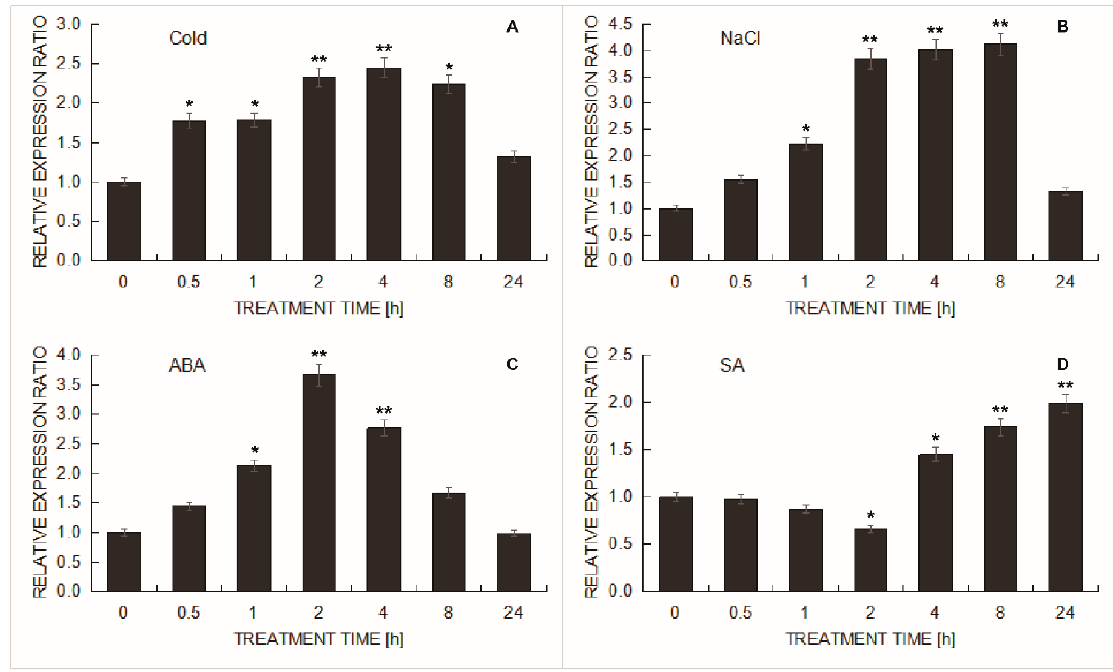
Figure 7. The expression patterns of BcHHP5 in Pak-choi under abiotic stress were analyzed by RT-qPCR. ( A ) Cold treatment, BcHHP5 expression; ( B ) salt treatment, BcHHP5 expression; ( C ) ABA treatment, BcHHP5 expression; ( D ) salicylic acid (SA) treatment, BcHHP5 expression. *: 0.01 < P < 0.05, **: P < 0.01.